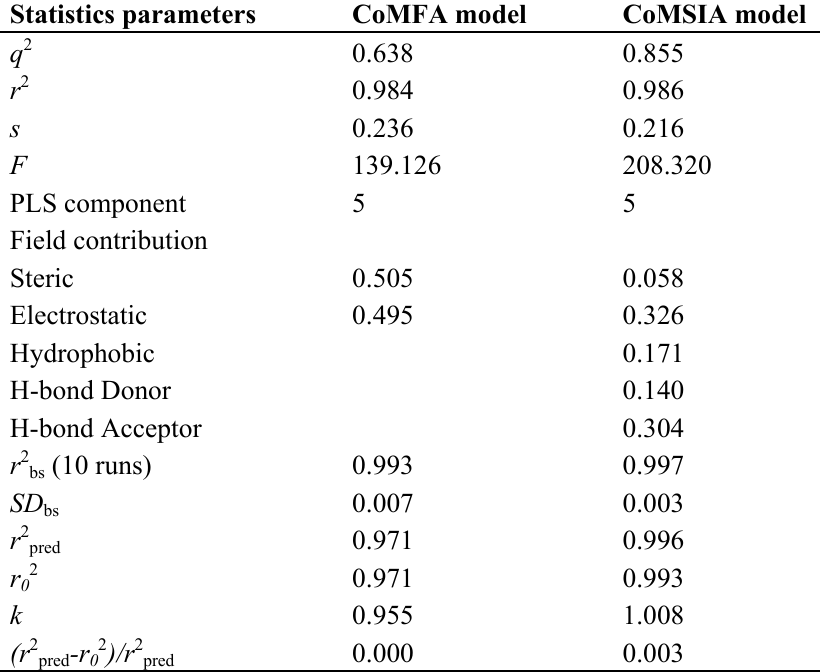
Table 1. Statistical parameters of the CoMFA and CoMSIA